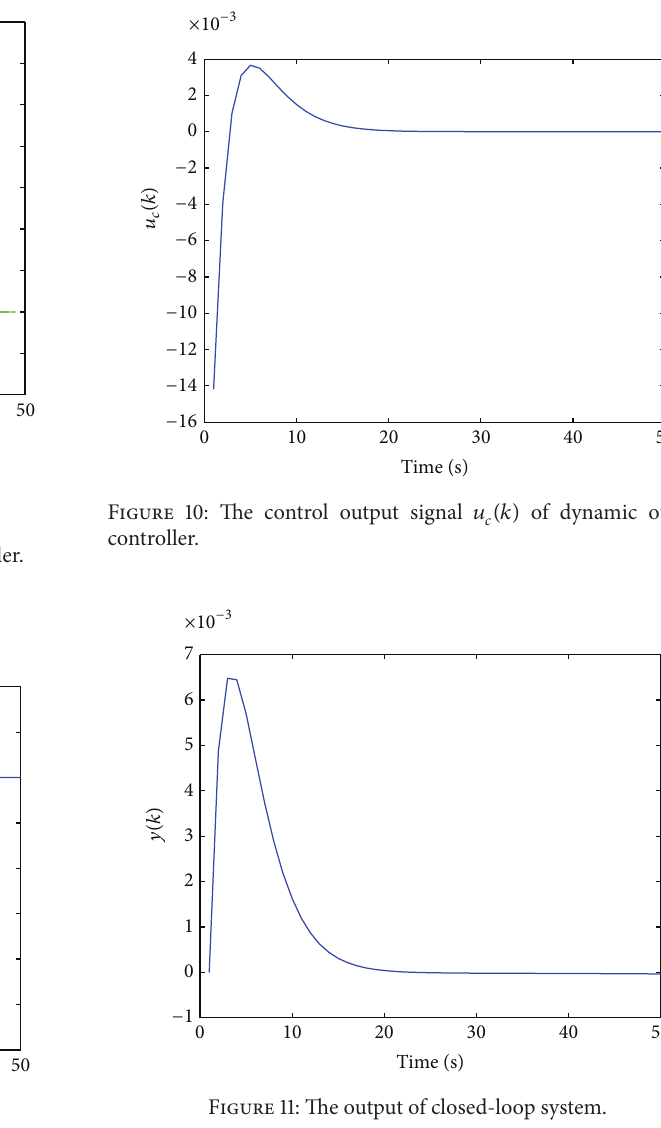
Figure 9: The control input signal 𝑢(𝑘) .